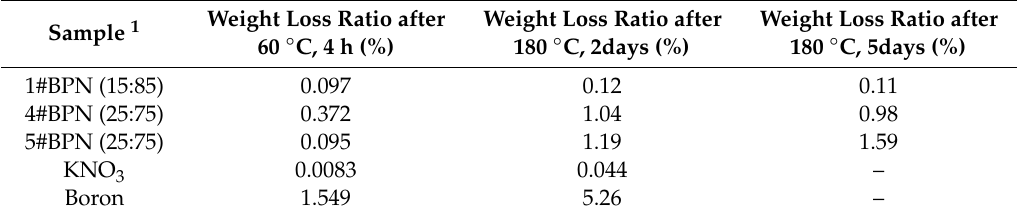
Table 6. Weight loss ratios of BPN samples in 180 ◦ C test.